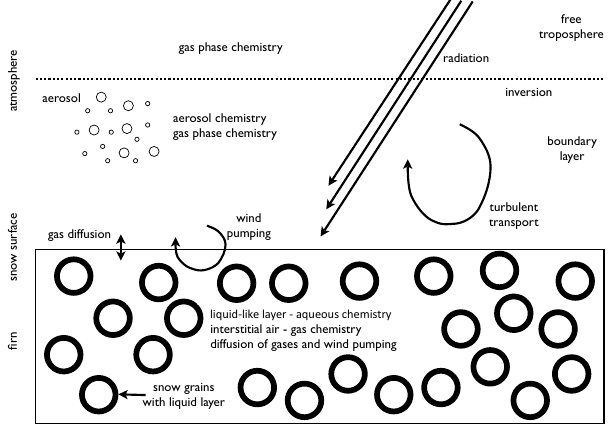
Fig. 1. Schematic depiction of the most important local processes controlling the atmospheric composition over sunlit snow. These processes are also included in the one-dimensional boundary layer model MISTRA-SNOW, where gas phase chemistry is calculated in all layers, aerosol chemistry is included in the boundary layer, and snow LLL chemistry is included below the snow